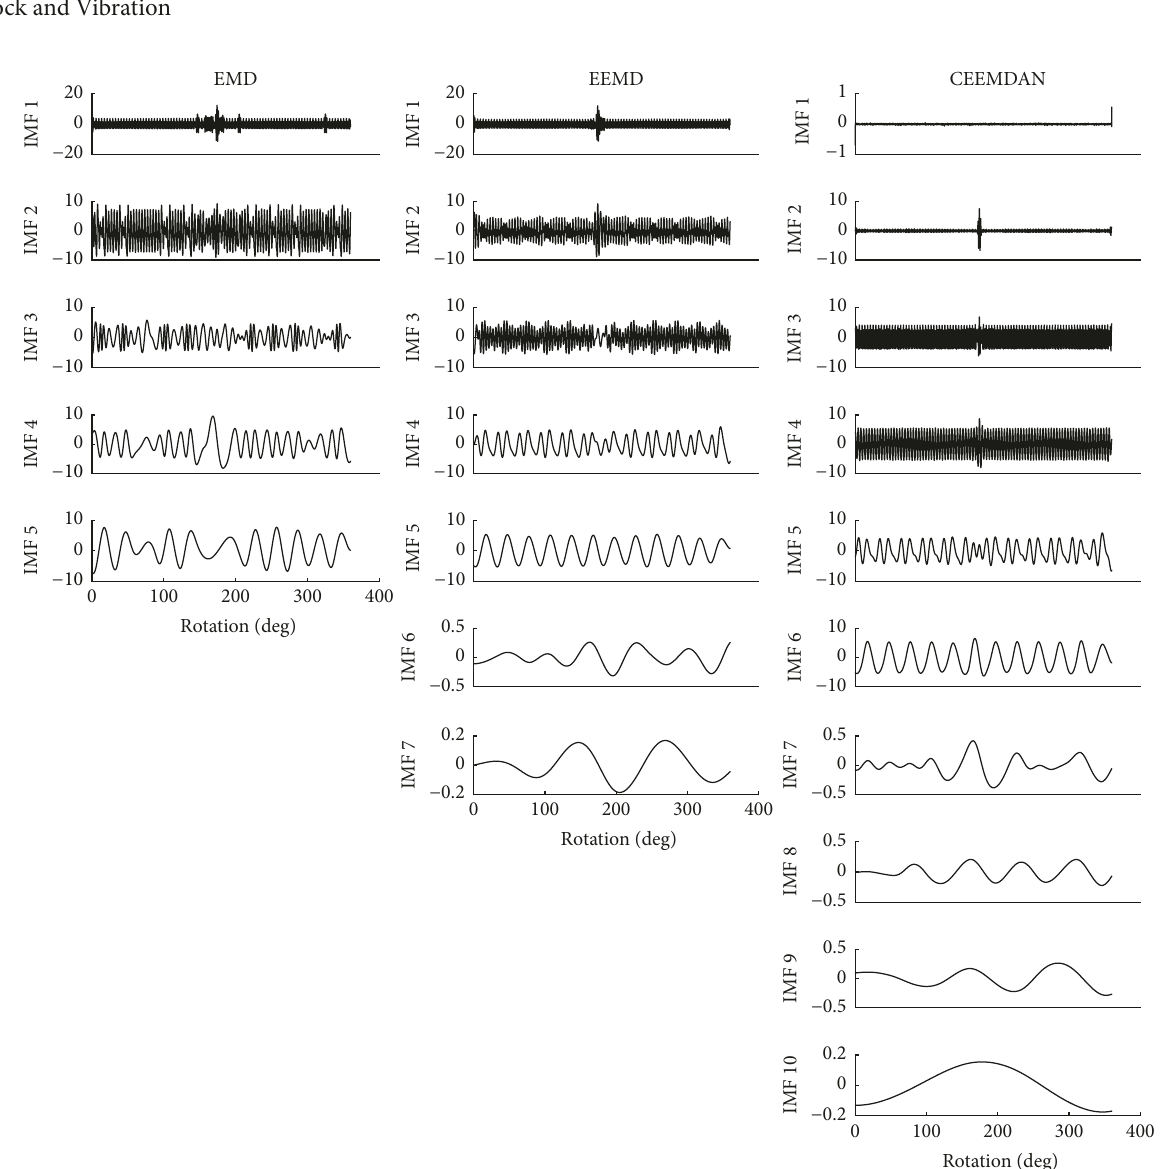
Figure 7: IMF sets of 𝑥 sim , II obtained by using EMD, EEMD, and